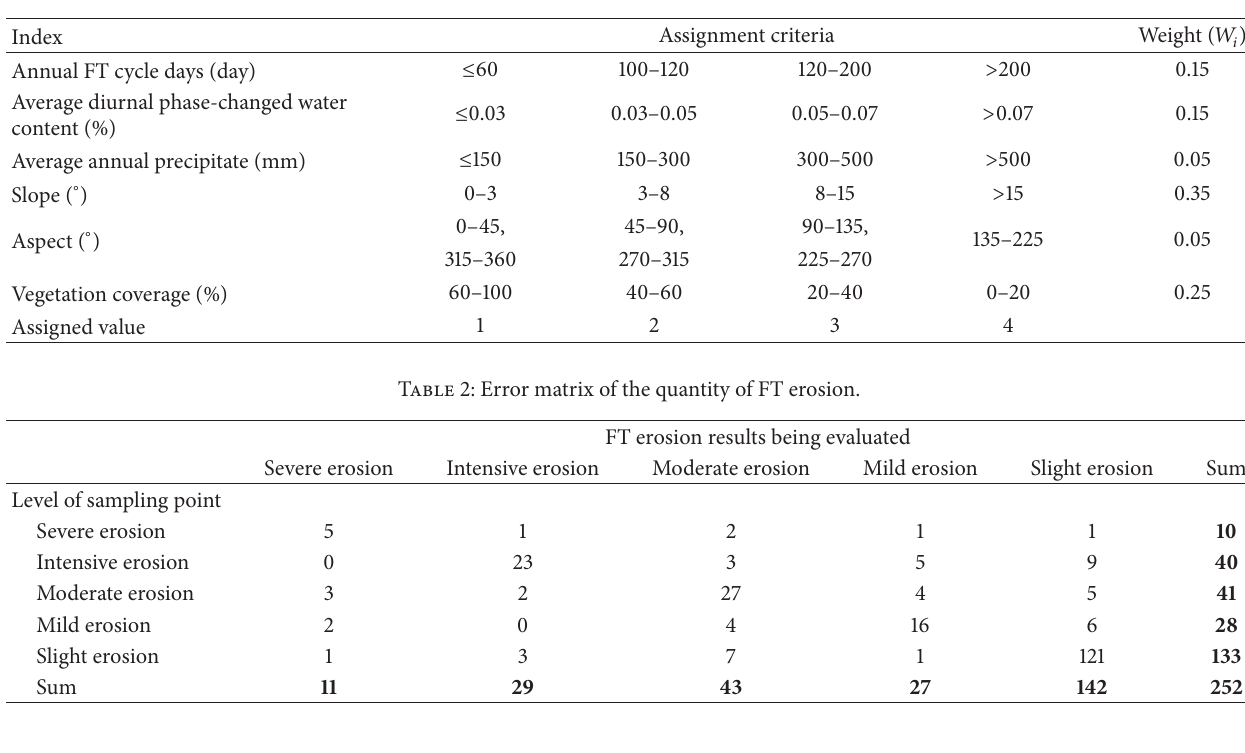
Table 1: Classification assignment of evaluation indices and their weights.